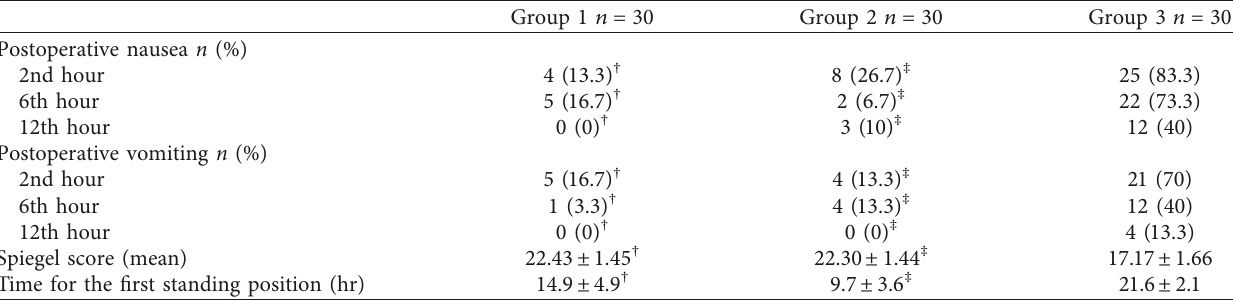
Figure 1: Postoperative shoulder pain intensity ((a) at rest and (b) at exertion). † p 2 and 3. Table 2: Effects of gabapentinoids on PONV, sleep quality, and first standing